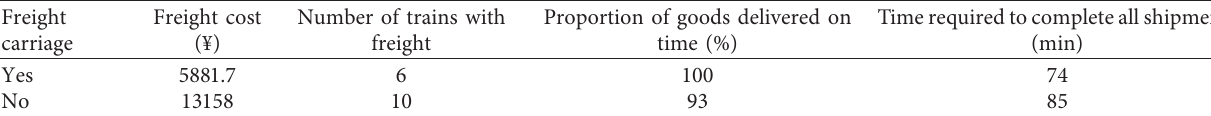
Figure 9: Metro freight plan operation diagram. Table 5: Calculation results.